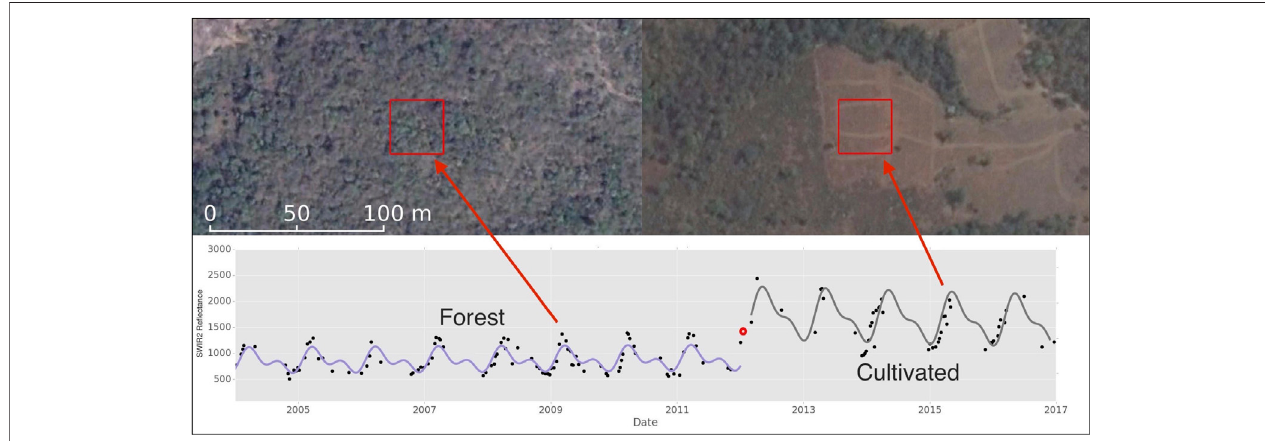
FIGURE2| CCDC results forasingle Landsat pixelinThailandthatwasconvertedfrom forest tocultivated land in2012. Thehigh-resolution imagesin thetoprow are from 2009 (before conversion) and 2015 (after conversion). The time series plot on the bottom shows all Landsat observations in the Landsat SWIR2 band (black dots), as well as the CCDC model fi ts (lines) and break point (red